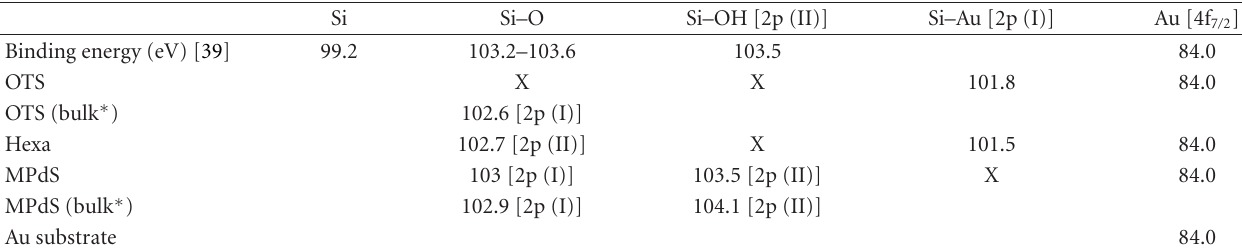
Figure 2: SEM images showing gold NPs (bright dots) adsorbed on top of an MPdS monolayer self-assembled on a gold film. (a) After adsorption, (b) after washing with acetone and ethanol under sonication and dipping in hot toluene. Table 1: High-resolution XPS data: peak position (eV) of Si 2p and Au 4f 7 / 2